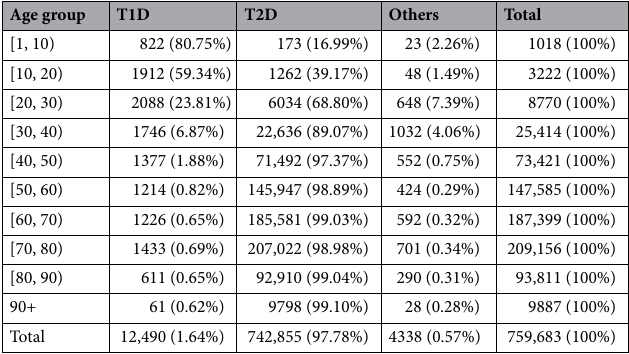
Table 1. The numbers and percentages of DM inpatients from 2002 to